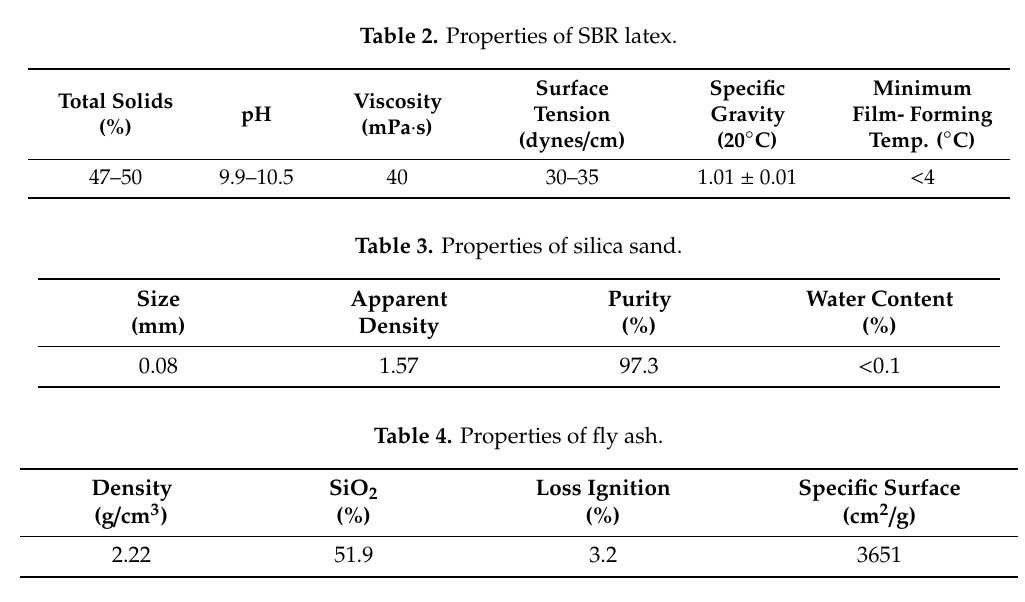
Table 5. Properties of silica fume.